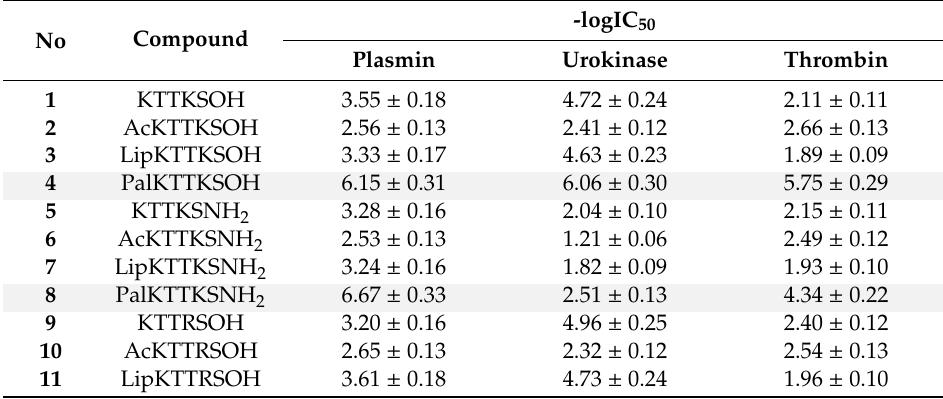
Table 2. Influence of the tested compounds on amidolytic activity of plasmin, urokinase, and thrombin in the form -logIC 50 (peptides most active as enzyme inhibitors are marked